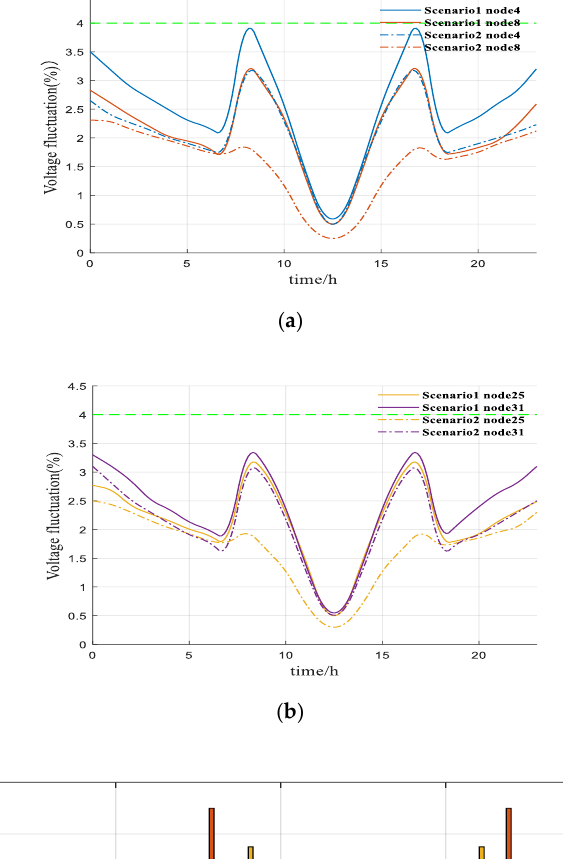
Figure 8. Voltage deviation curve. ( a ) Comparison of sub-scenarios of nodes 4 and 8. ( b ) Comparison of sub-scenarios of nodes 25 and 31. ( c ) Percentage improvement of voltage deviation relative to standard value.